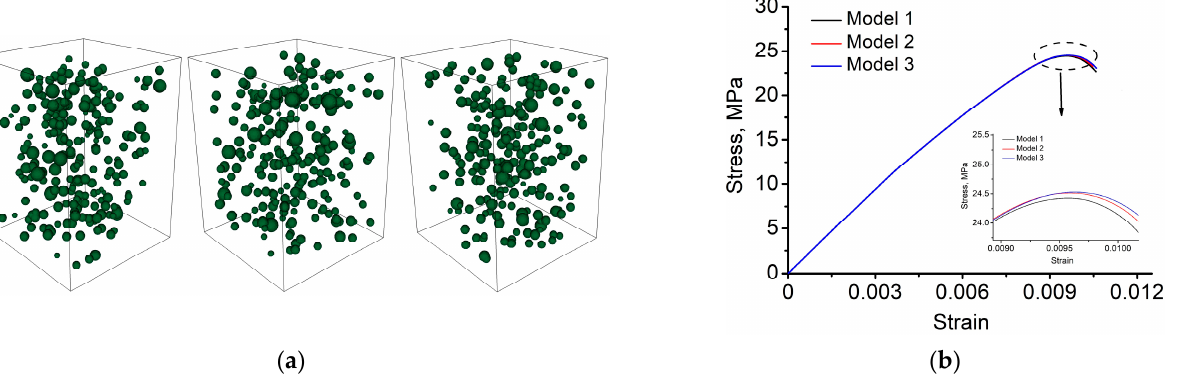
Figure A6. Three different designed structural models with stochastic distribution of pores in computational domain having identical integral porosity ( a ), stress-strain curves obtained for these three models using the same set of parameters ( b ).